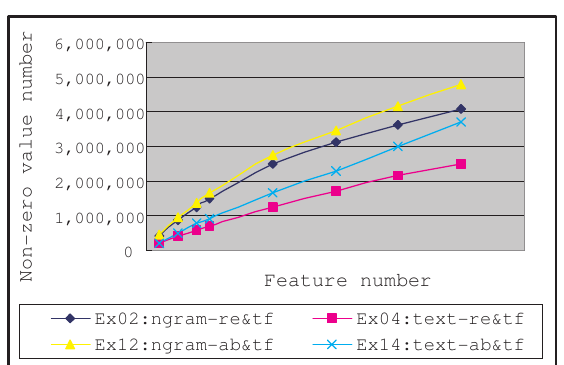
Fig. 2. Performance comparison on four kinds of features selection methods (on Bayes classifier).